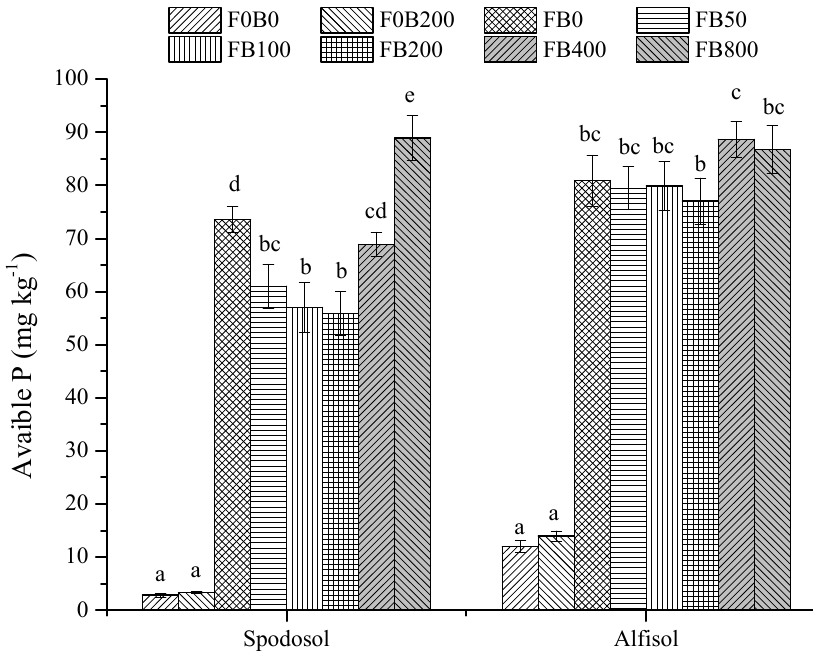
Figure 7. Available P in Spodosol and Alfisol soils affected by different application rates of CNPs. F0B0, control (without fertilizers and CNPs); F0B200, without fertilizers and with CNPs at 200 mg kg − 1 soil; and FB0, FB50, FB100, FB200, FB400 and FB800 represent those with and CNPs at application rates of 0, 50, 100, 200, 400 and 800 mg kg − 1 soil, respectively. Error bars represent the standard error of the mean ( n = 5). The letters a, b, c, d and e indicate statistically significant difference at p < 0.05 within each group comparison between the treatments. Bars with no common letters are significantly different ( p < 0.05).